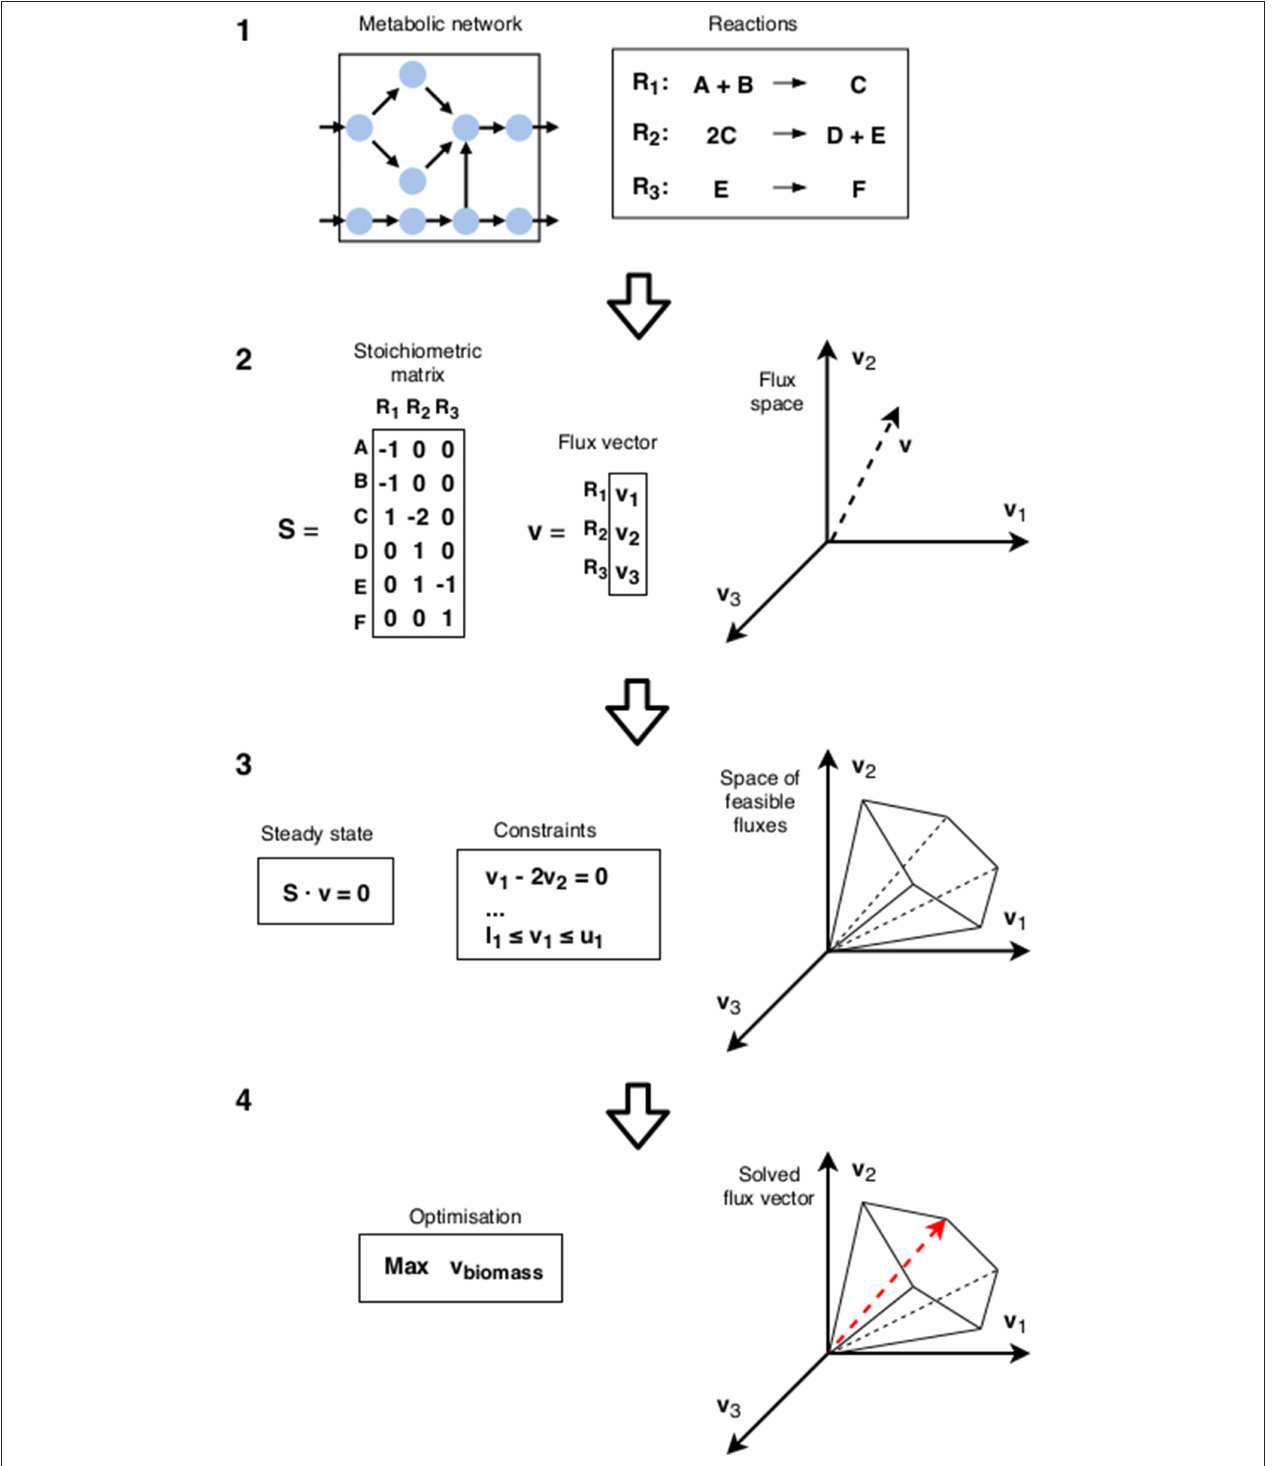
FIGURE 2 | Flux Balance Analysis: (1) The starting point is the metabolic reconstruction. (2) The flux space is a space of possible flux vectors v . (3) Constraints are imposed on the flux space: the steady state condition requires that the net production of all internal metabolites equals zero. This confines the flux vector into a cone-shaped subspace. The upper and lower bounds ( l i and u i ) of the reactions bound the cone, establishing a maximum magnitude. (4) Finally, using linear programming, an objective function (usually a linear combination of certain reaction fluxes that corresponds to a biological objective such as biomass) is maximized to find the predicted flux